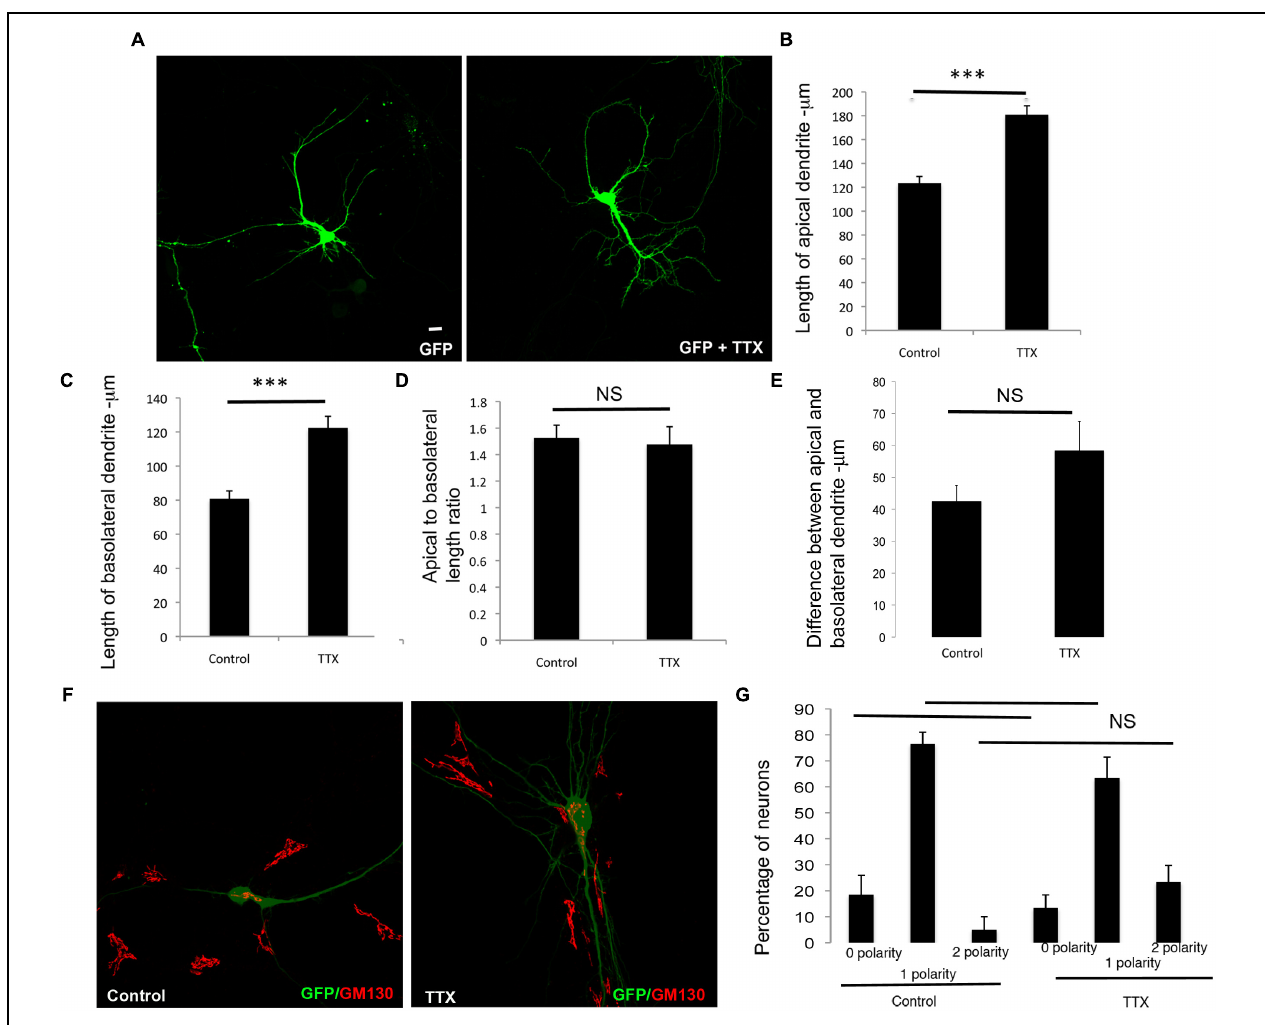
FIGURE 4 | Global chronic inhibition of activity promotes net extension of both apical and basolateral dendrites. (A) Representative confocal images of neurons transfected with GFP and chronically treated with or without TTX. (B) Length of apical dendrite. (C) Length of basolateral dendrite. (D) Ratio of lengths of apical to basolateral dendrites, and (E) Difference between apical and basolateral dendrite lengths in neurons expressing GFP chronically treated